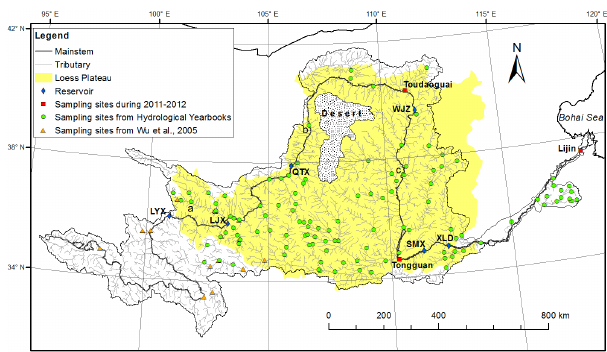
Figure 1. Location map of the sampling sites in the Yellow River watershed. Acronyms for the mainstem dams: LYX – Longyangxia since 1986; LJX – Liujiaxia since 1968; QTX – Qingtongxia since 1968; WJZ – Wanjiazhai since 1998; SMX – Sanmenxia since 1960; and XLD – Xiaolangdi since